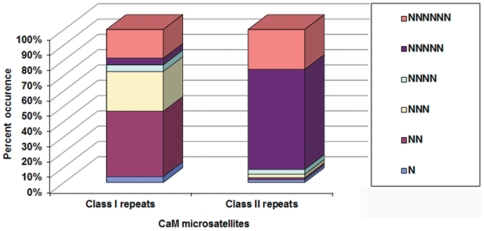
Distribution of Class I and Class II repeats in newly isolated chickpea microsatellites.Class I microsatellites contain >20 nucleotides, Class II repeats perfect SSRs with >12 but <20 nucleotides. Among Class I repeats, tri-nucleotide repeats were most abundant, followed by di-nucleotide repeats, while in Class II repeats, penta-nucleotide repeats were most prevalent, followed by hexa-repeats. N, mono-nucleotide repeats; NN, di-nucleotide repeats; NNN, tri-nucleotide repeats; NNNN, tetra-nucleotide repeats; NNNNN, penta-nucleotide repeats, NNNNNN, hexa-nucleotide repeats.